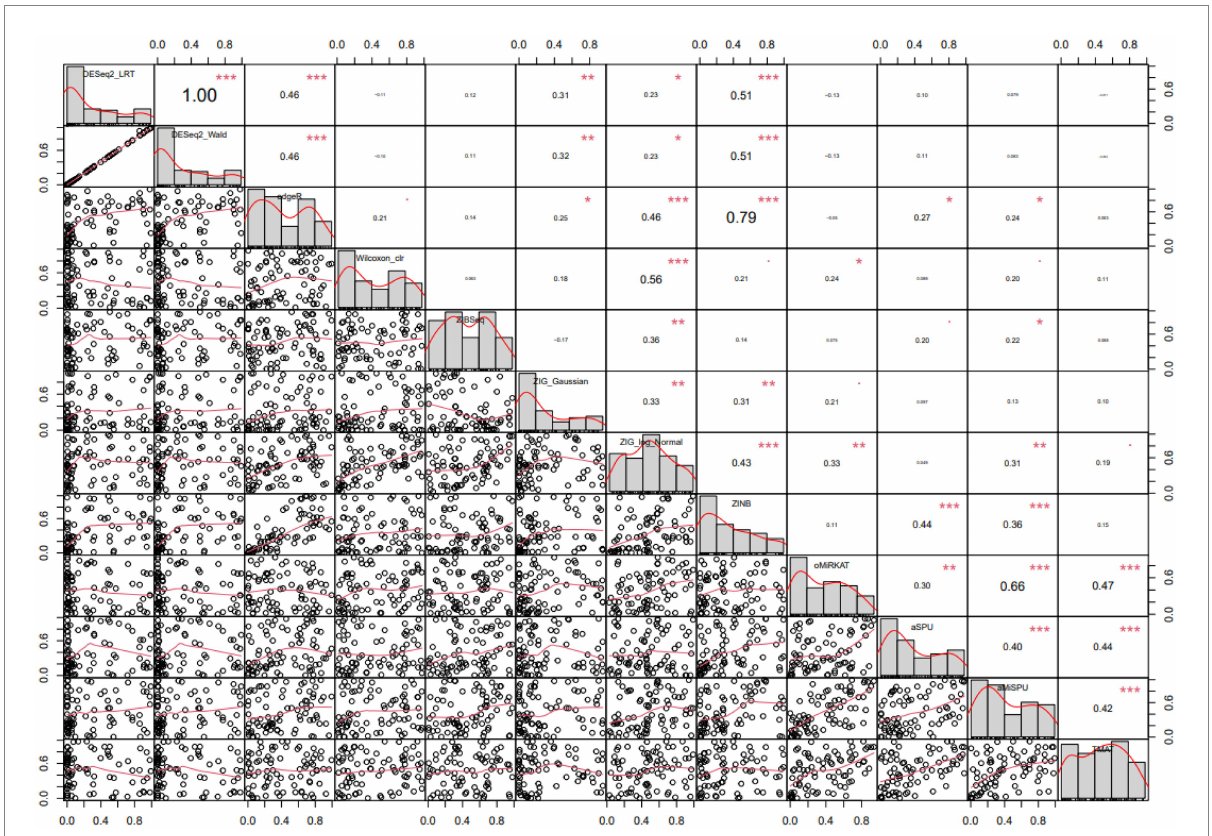
FIGURE 5 Pairwise Spearman correlation coefficients computed from various statistical methods. Spearman correlation of each pair of methods are represented in the upper diagonal graphs. The bigger the numbers the stronger the correlation. Lower diagonal scatterplots represent p -values. Diagonal graphs with the method name have histogram of p-values. Methods are in the order of DESeq2[LRT/Wald], edgeR, Wilcoxon CLR, ZIBSeq, ZIG[Gaussian/log normal], ZINB, oMiRKAT, aSPU, aMiSPU,